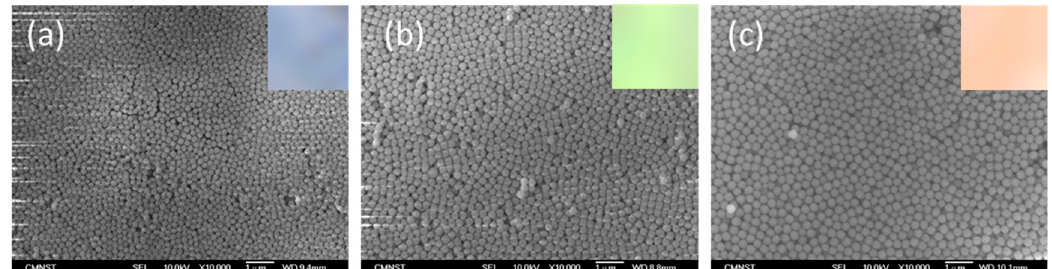
Figure 6. Microstructures of various structure-colored samples: ( a ) Blue, ( b ) green, and ( c ) red. Sample color is shown in the corner of each image.